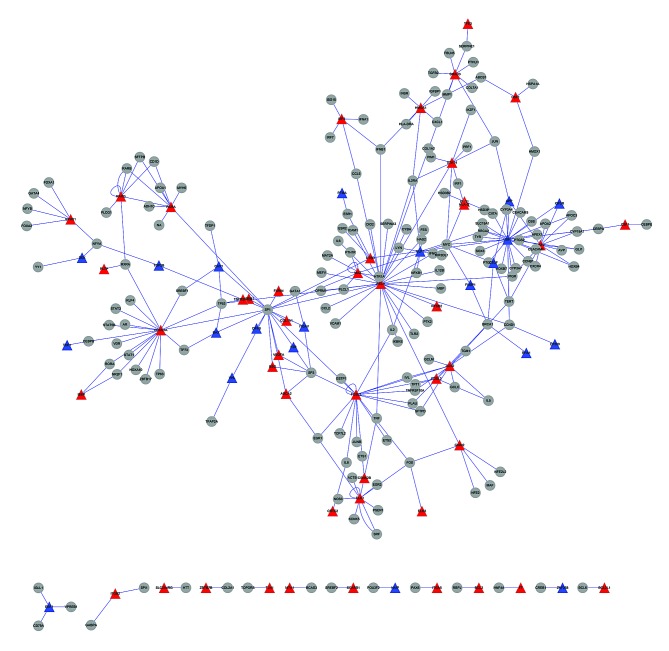
Transcriptional regulatory network for DEGs. The red, blue and grey nodes, and grey edges represent the upregulated DEGs, downregulated DEGs, other genes and transcriptional regulation associations, respectively. DEGs, differentially expressed genes.